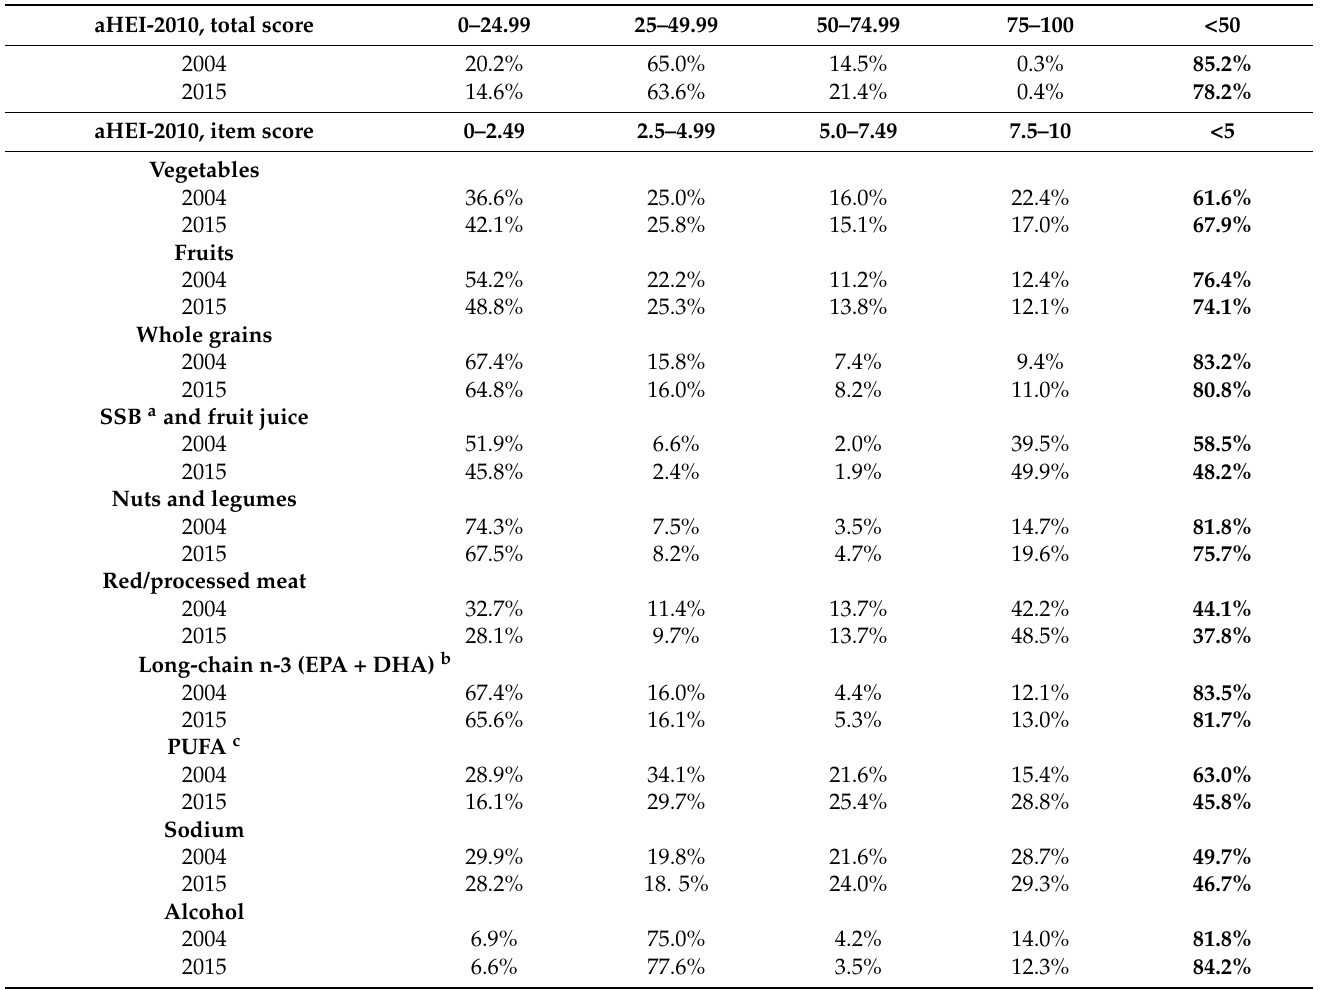
Table 5. Distribution of alternate Healthy Eating Index 2010 (aHEI-2010) scores in adults from the Canadian Community Health Survey (CCHS)-Nutrition in 2004 and